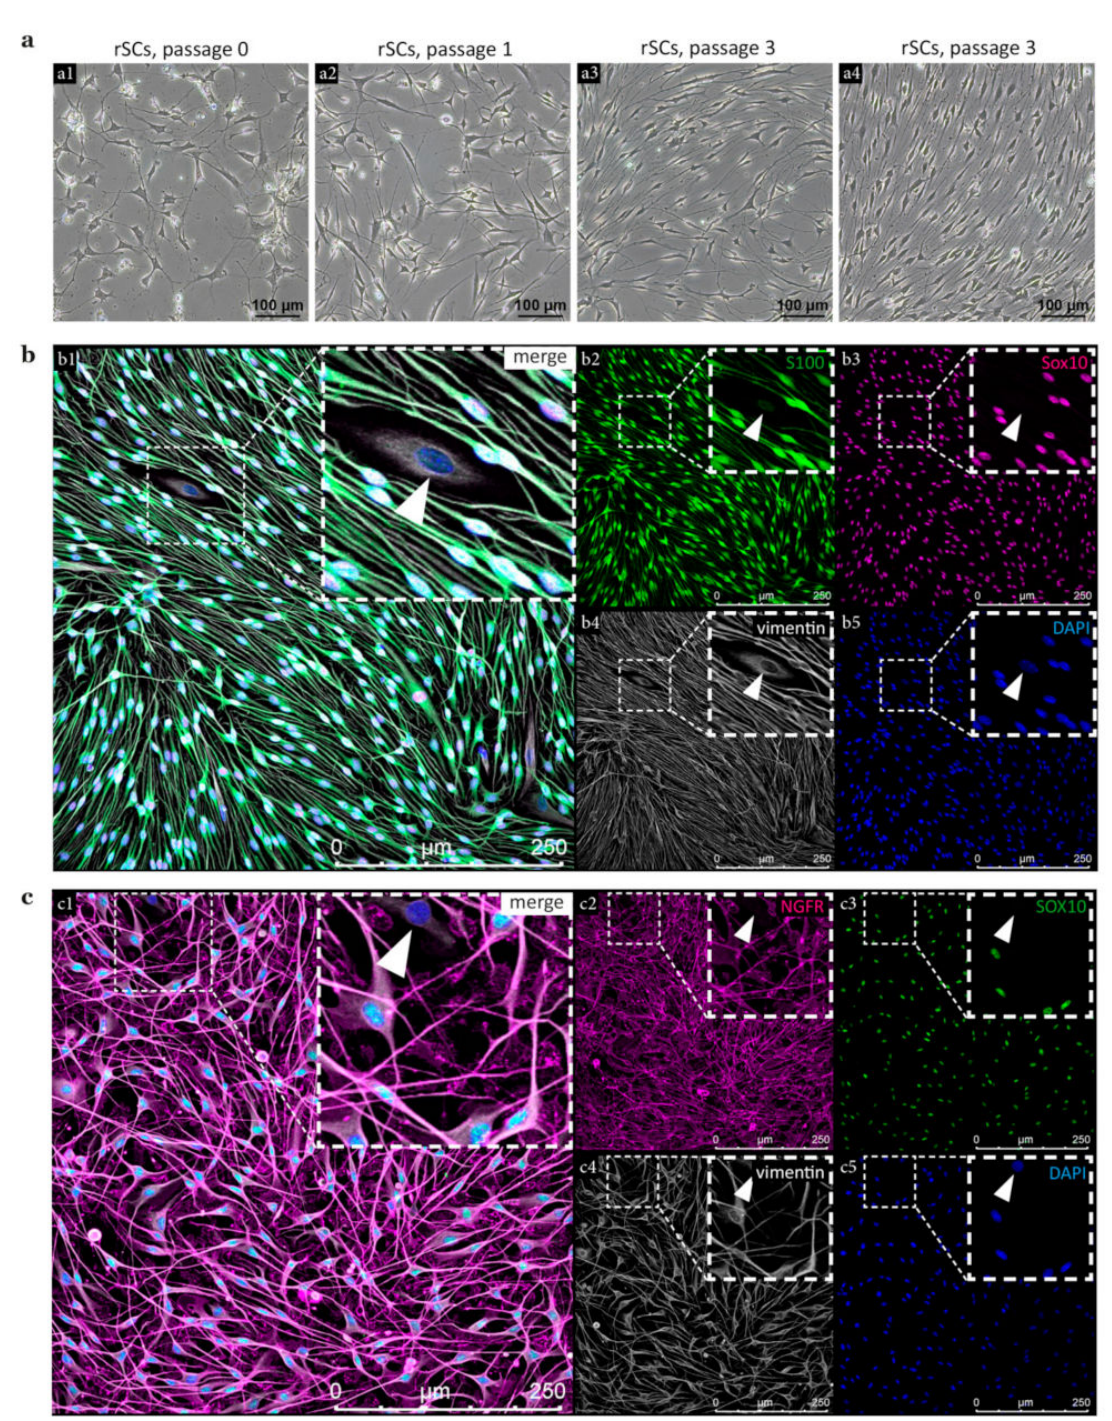
Figure 3. Characterisation of rSCs. ( a ) Phase contrast images of rSCs in p0 ( a1 ), p1 ( a2 ), and p3 ( a3 , a4 ). ( b ) Immunofluorescence staining of p3 rSC cultures showing merged staining channels ( b1 ) and single staining channels for S100 ( b2 ), SOX10 ( b3 ), vimentin ( b4 ), DAPI ( b5 ); arrowheads indicate a SOX10 − FB with weak S100 + signals in the nucleus. ( c ) Immunofluorescence staining of p3 rSC cultures showing merged staining channels ( c1 ) and single staining channels for NGFR ( c2 ), SOX10 ( c3 ), vimentin ( c4 ), DAPI ( c5 ); arrowheads indicate a NGFR − / SOX10 −